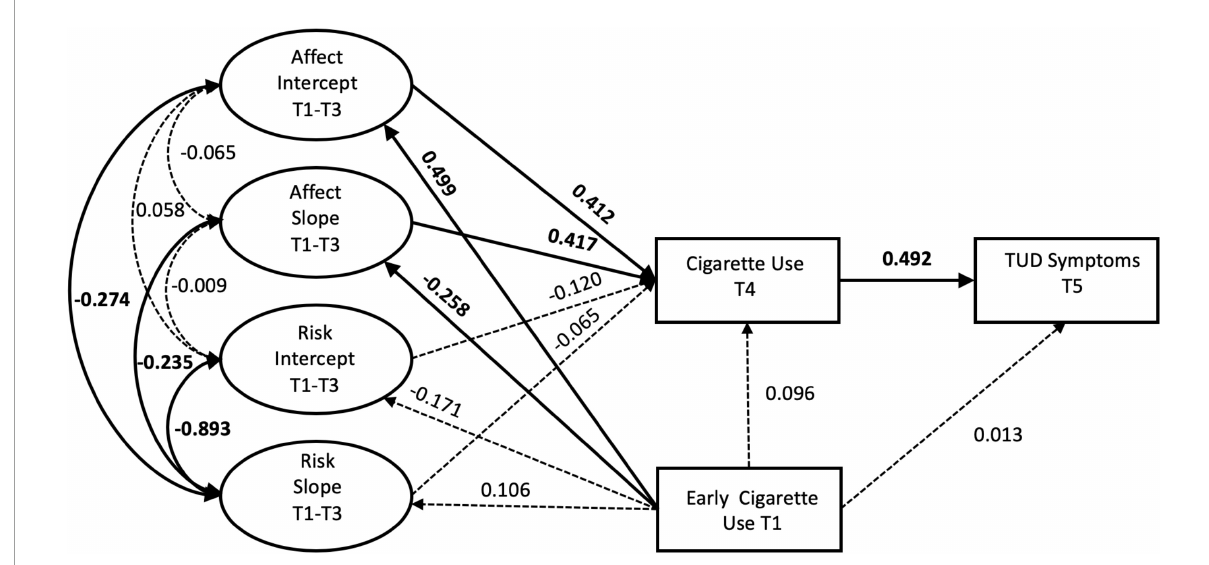
FIGURE2 Final model with standardized path estimates. Bolded estimates with solid lines represent significant paths ( p < 0.05), non-bolded estimates and dotted lines represent non-significant ( p > 0.05) paths. Covariates, mean structure, and manifest variables for affect and risk not